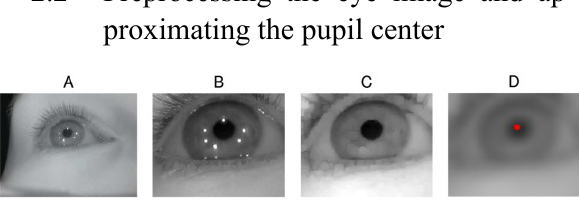
Figure 2. An example of a captured eye image (A) which is cropped (B), morphologically opened (C), and filtered (D). The filtered image shows also the estimated pupil center which is used later in estimating the glint loca- tions and pupil